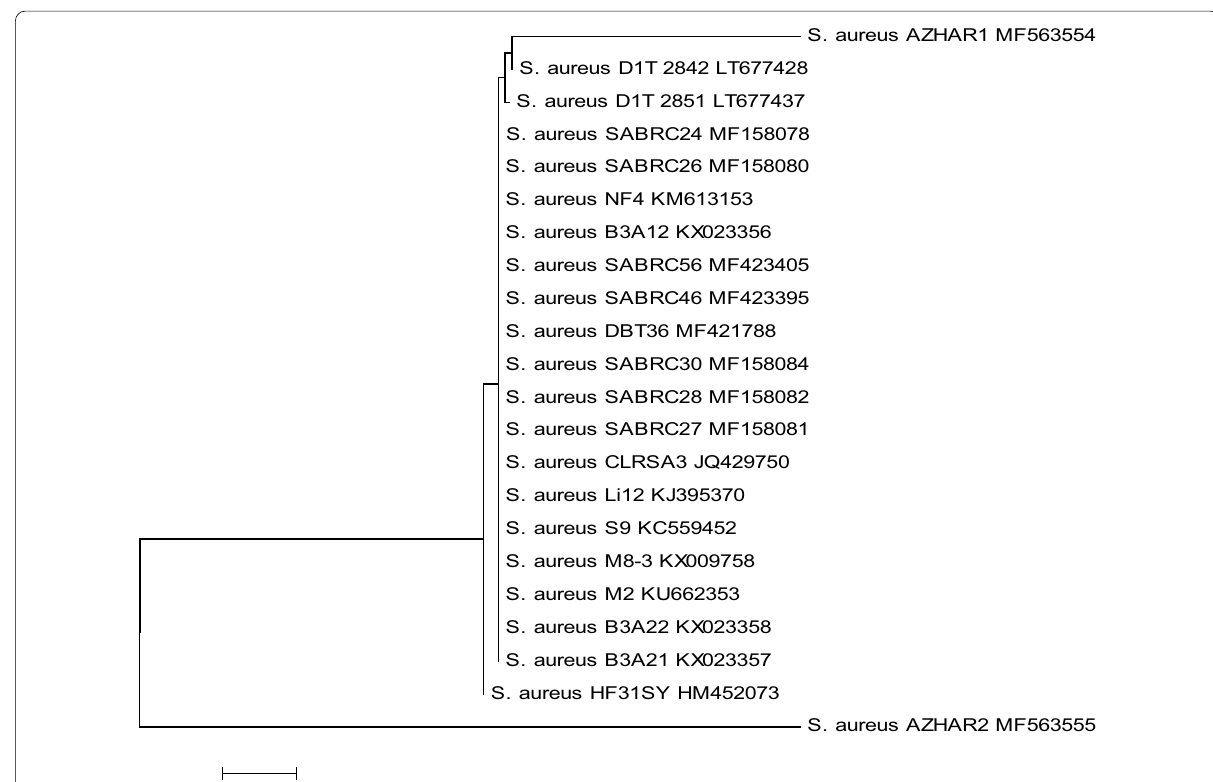
Fig. 4 Phylogenetic tree of 1500 bp of 16S rRNA gene of S. aureus MF563554, MF563555, compared with other strains available in GeneBank using neighbor‑joining distance method